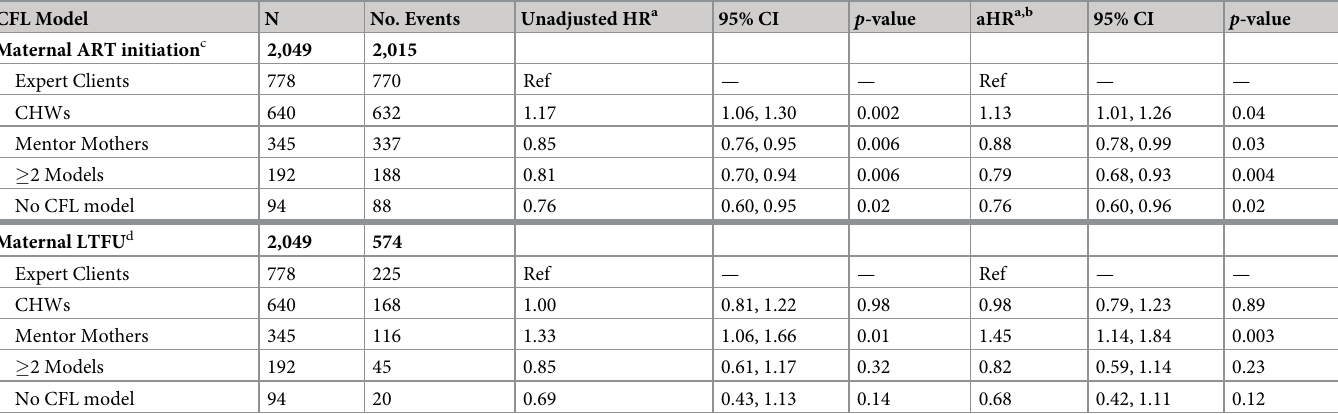
Table 2. Comparisons of maternal ART initiation and PMTCT/ART program LTFU by CFL model among PBFW living with HIV ( N = 2,049). CFL Model